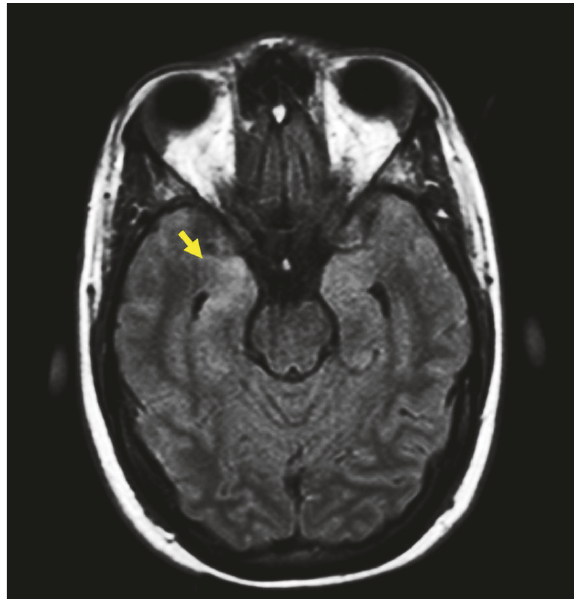
Figure 1: BrainMRI of patient with positive Anti-NMDAR encephali- tis . Arrow shows cortical hyperintensity in uncus right and hip- pocampus with T2-FLAIR